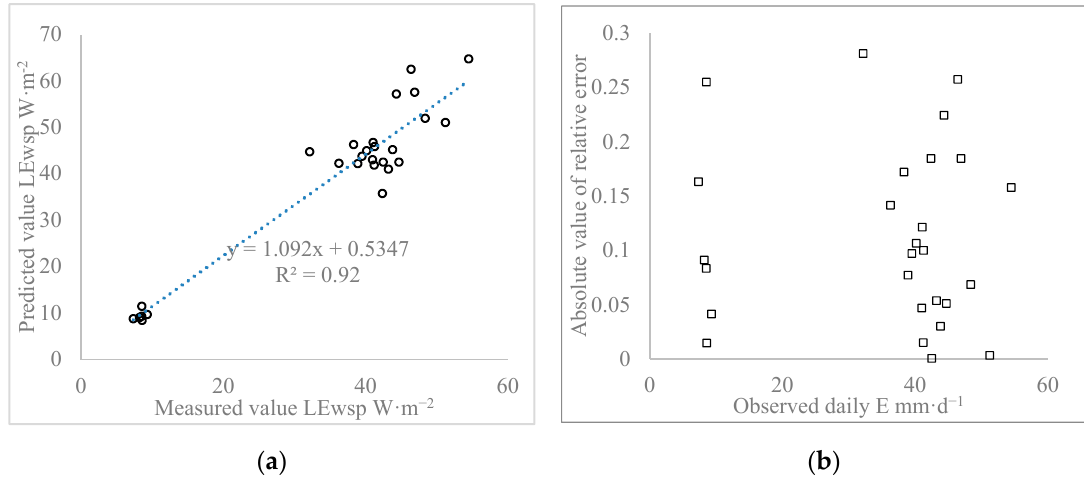
Figure 4. ( a ) The linear relationship between the predicted and measured values of LE wsp ; ( b ) Scatter plot between observed daily and absolute value of relative error